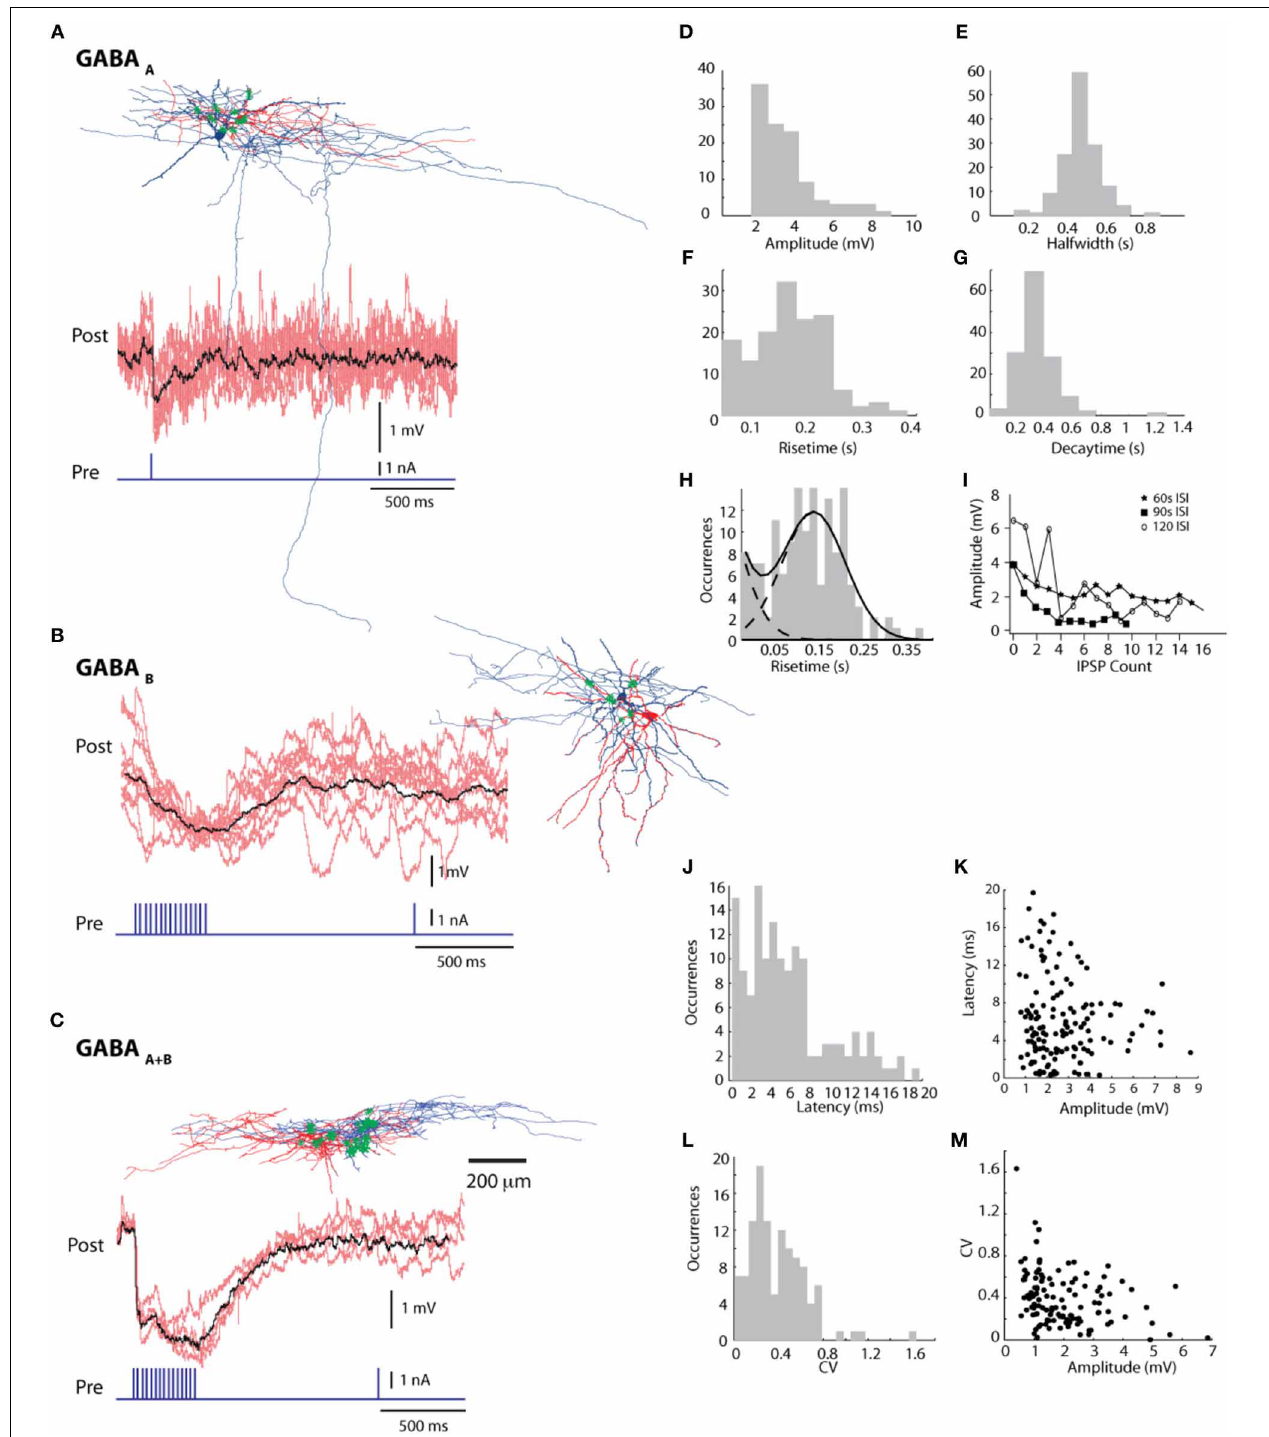
FIGURE 5 | Synaptic connections between L1 cells. (A) GABA A , (B) GABA B , and (C) GABA A + B connections; individual traces in red and mean in black. Reconstruction of a pair of cells with for each type connection— pre-synaptic in blue and post-synaptic in red, points of contact marked with green asterisks. See Supplementary Figure 7 for positions of putative contact points. Histograms of synaptic parameters— (D) amplitude, (E) halfwidth, (F) risetime and (G) decaytime. (H) The risetime histogram